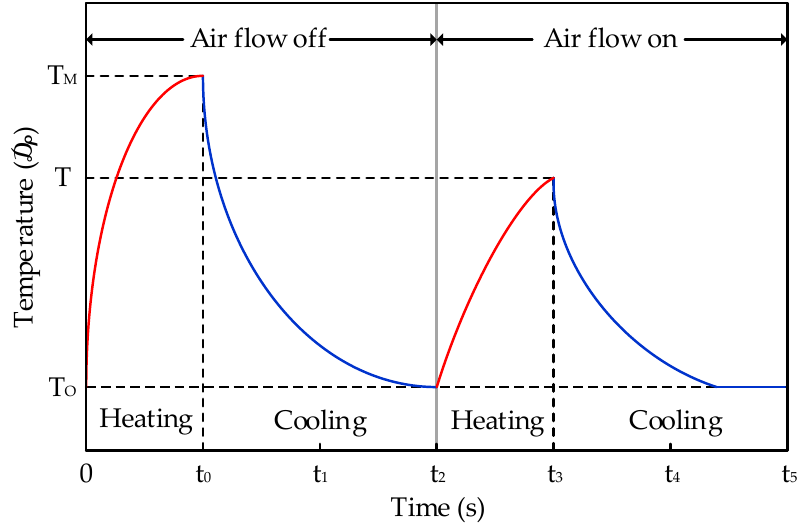
Figure 3. Operation principle of the micro anemometer air flow sensor.